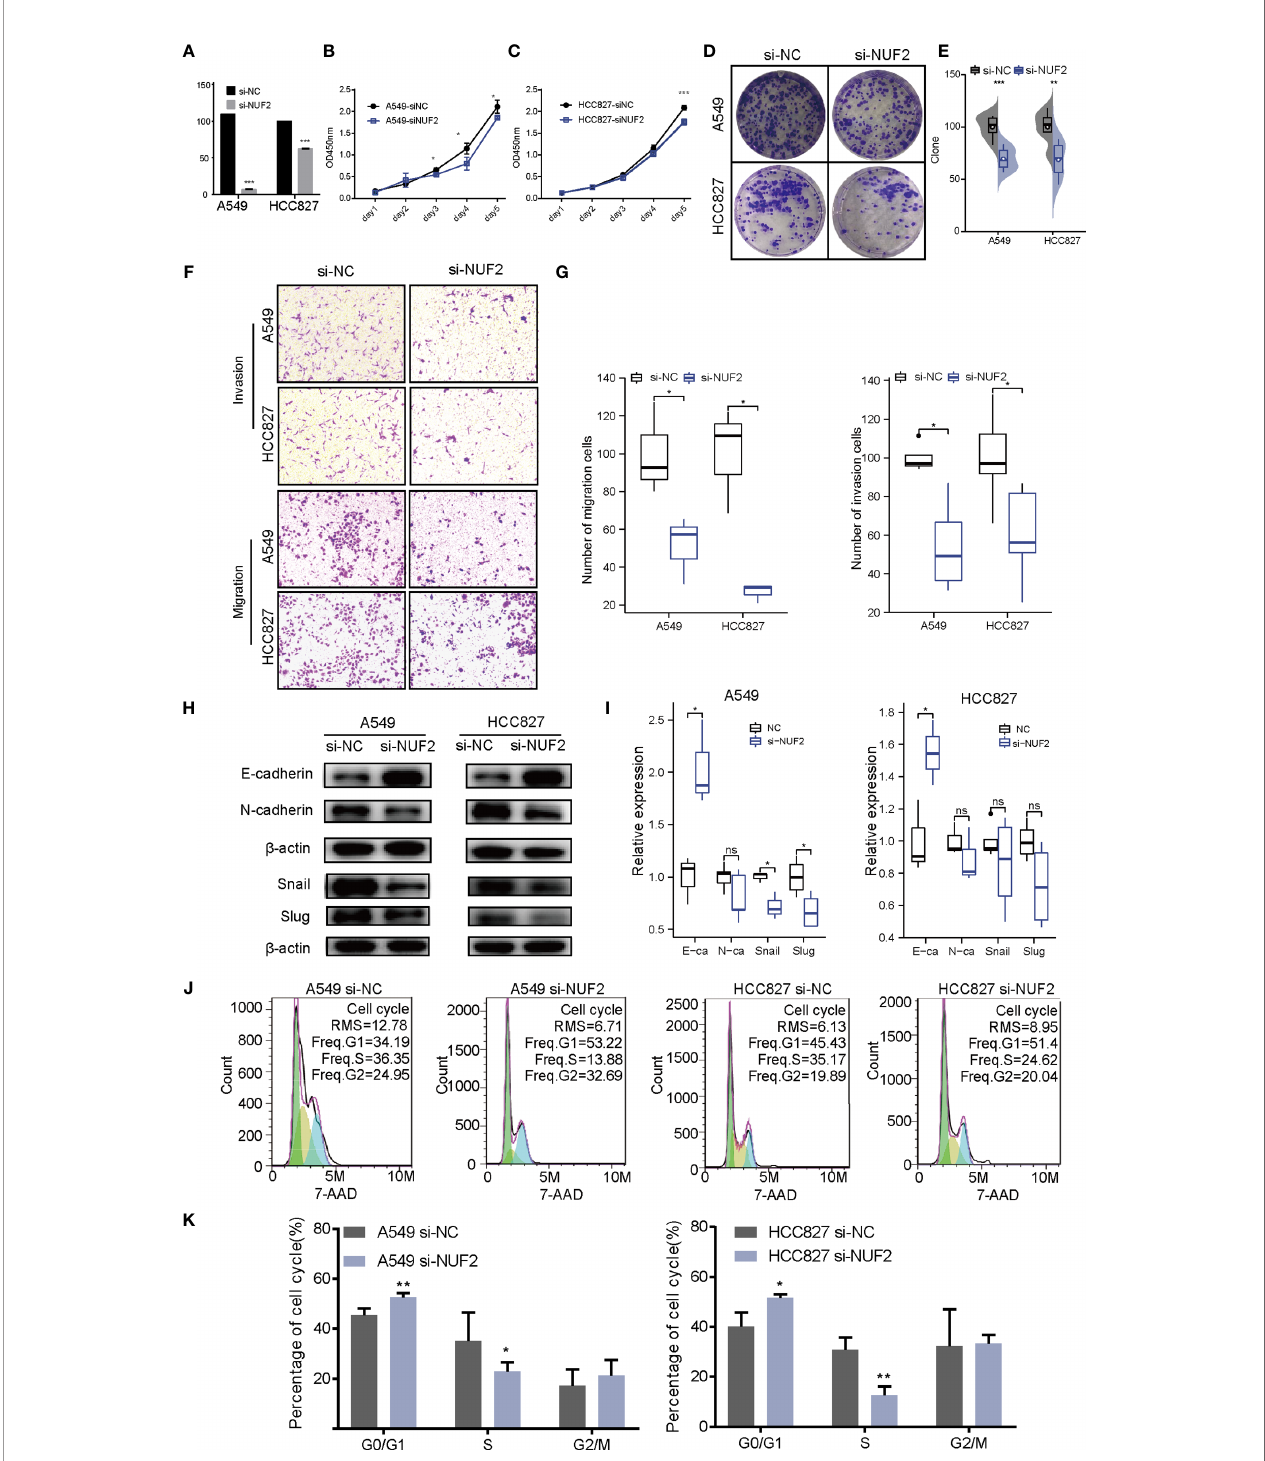
FIGURE 7 | Biological function of NUF2 in lung adenocarcinoma (LUAD) cells. (A) Reverse transcription-quantitative polymerase chain reaction analysis of NUF2 in A549 and HCC827 cells transfected with si-NC or si-NUF2. (B, C) Cell proliferation rates as determined by CCK8 assays in A549 and HCC827 cells transfected with control si-NC or si-NUF2. (D, E) Colony formation assay for evaluating the clonogenic ability of A549 and HCC827 cells. (F, G) The invasive ability of A549 and HCC827 cells was detected by transwell assay. (H, I) Expression of epithelial-mesenchymal transition markers in NUF2-silenced samples as measured using western blotting assays. (J, K) Effect of NUF2 knockdown on cell cycle progression. ***p < 0.001,**p < 0.01,*p <